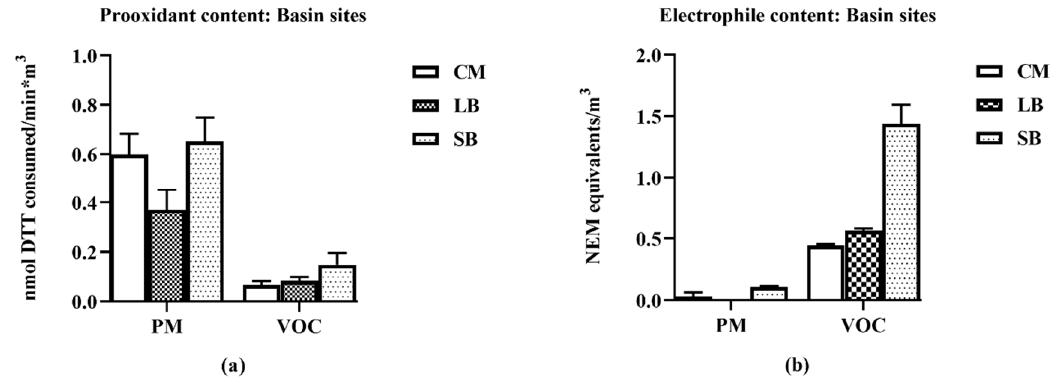
Figure 3. Chemical properties of particulate matter (PM) and volatile organic compound (VOC) air samples collected at CM, LB and SB. For each region’s PM and VOC samples, nmol dithiothreitol (DTT) consumed (prooxidant content ( a )) and N-ethylmaleimide (NEM) equivalents derived from a glyceraldehyde 3-phosphate dehydrogenase (GAPDH)-inhibition assay (electrophile content ( b )) were measured. The VOCs represent the dichloromethane extracts of XAD resin traps of the vapor phases. Error bars indicate 95% CI (n = 3) for DTT results; SEM (n = 3) for the NEM results (values of the CIs are detailed in supplemental data—Table S1).